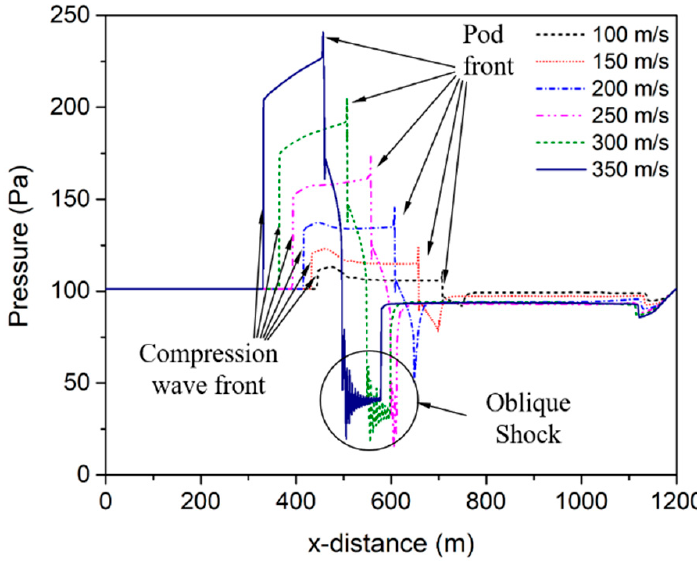
Figure 13. Pressure wave distribution along the centerline of the tube and pod surface at t = 1.0 s. Four cases of selected pod speeds under P tube = 101.325 Pa, L = 43 m, and BR = 0.36 are presented. Pod moves from right to left.